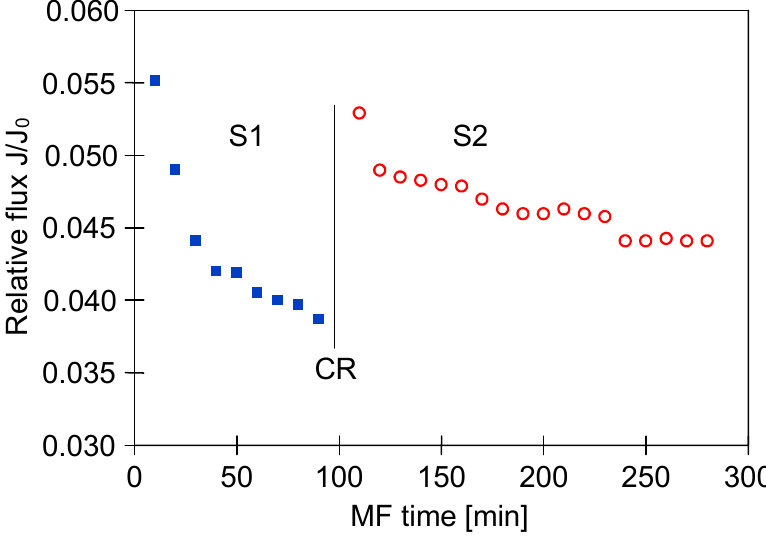
Figure 22. Changes in relative permeate flux during the MF process of yeast suspension with peri-